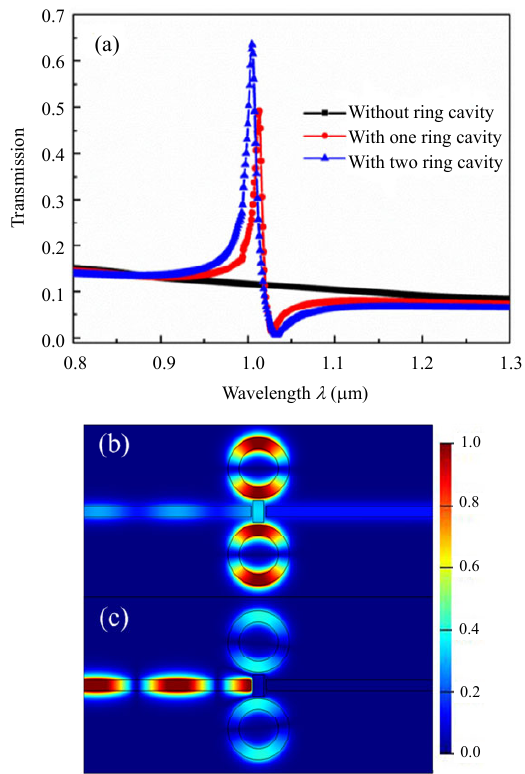
Fig. 2 Transmission spectra of MIM waveguides coupled with (a) one ring, two rings resonant cavities, and by a rectangular cavity only; the contour profiles of field H z of the waveguides coupled with rectangular and two shunt-wound rings resonator at (b) λ = 1005 nm and (c) λ = 1033